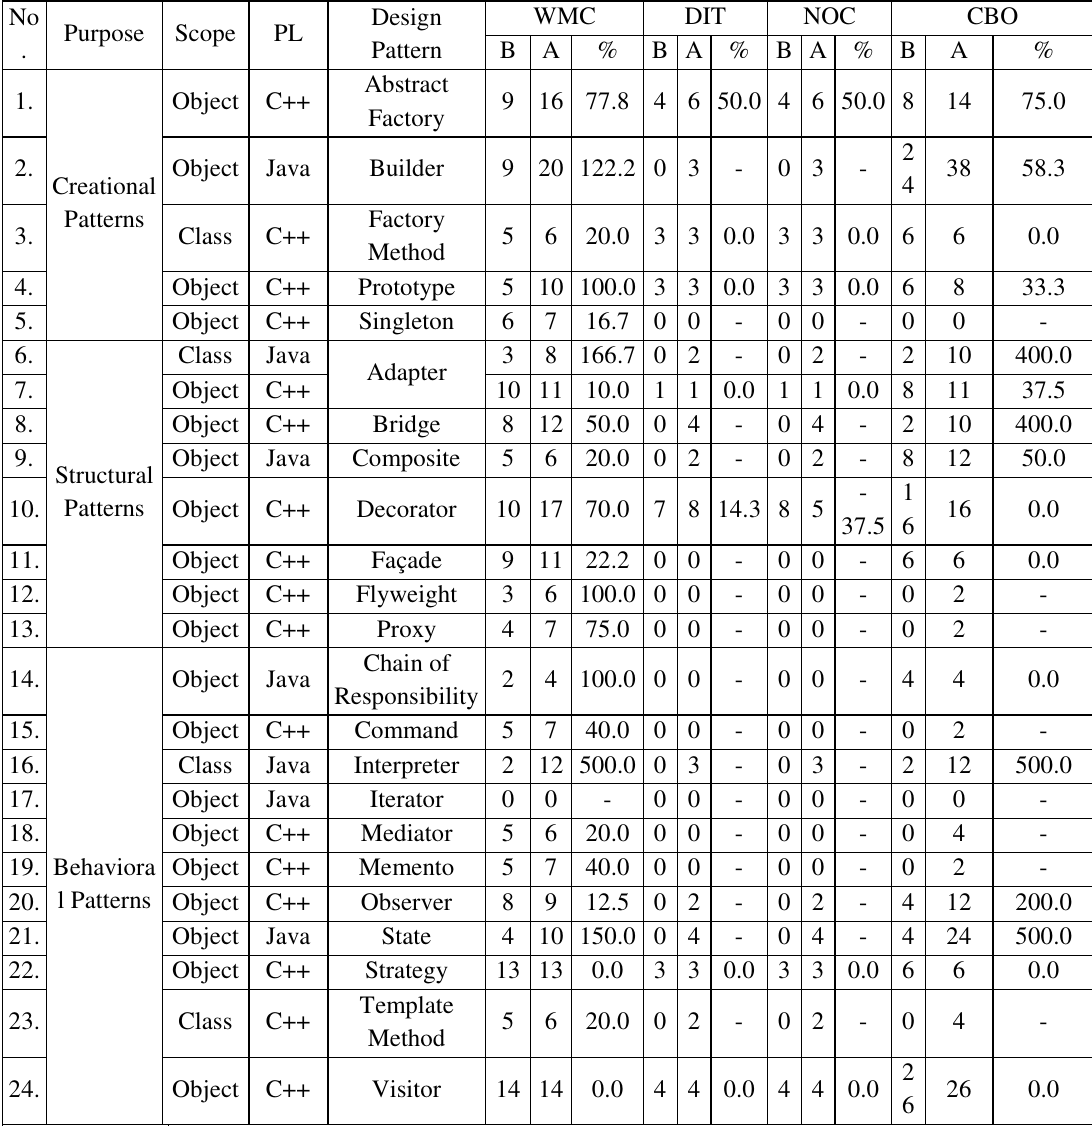
TABLE 4. BEFORE AND AFTER USING DESIGN PATTERNS – CK METRICS COMPARISON No